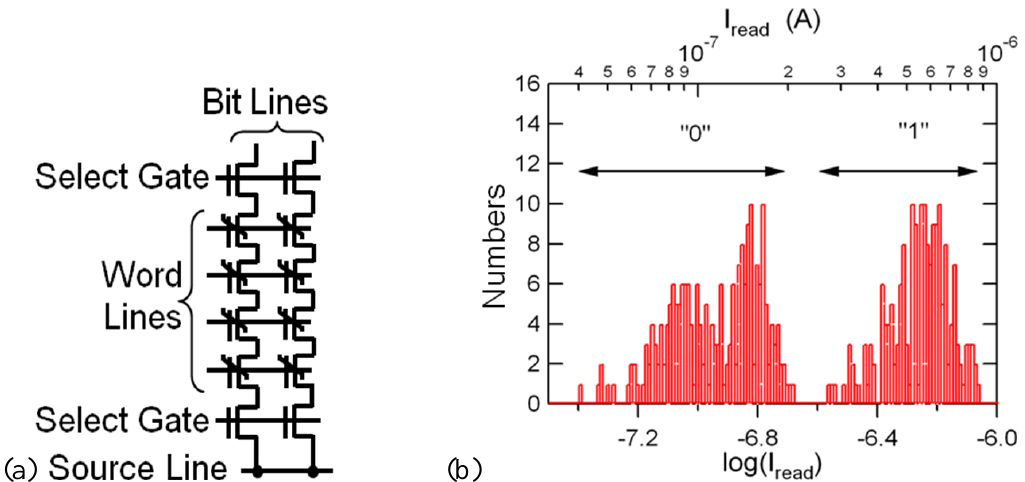
Figure 13. (a) Equivalent circuit of a 4 × 2 FeNAND memory cell array and (b) distribution of accumulated bit-line currents of 51 programmed patterns, which were measured every time after an erase-and-program cycle. Reproduced from [42] with permission of IOP Publishing